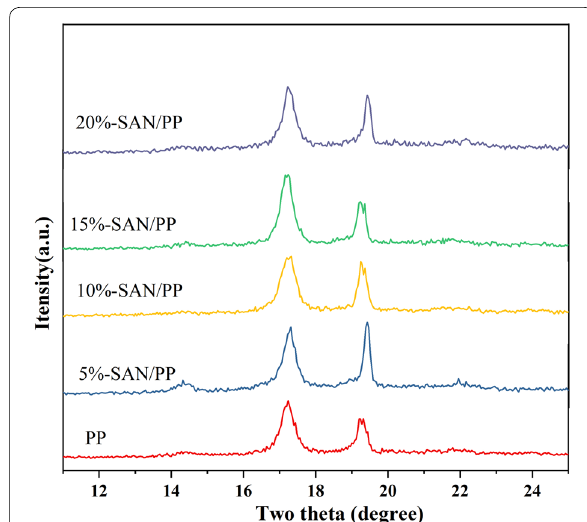
Fig. 1 XRD patterns of PP and SAN/PP blends